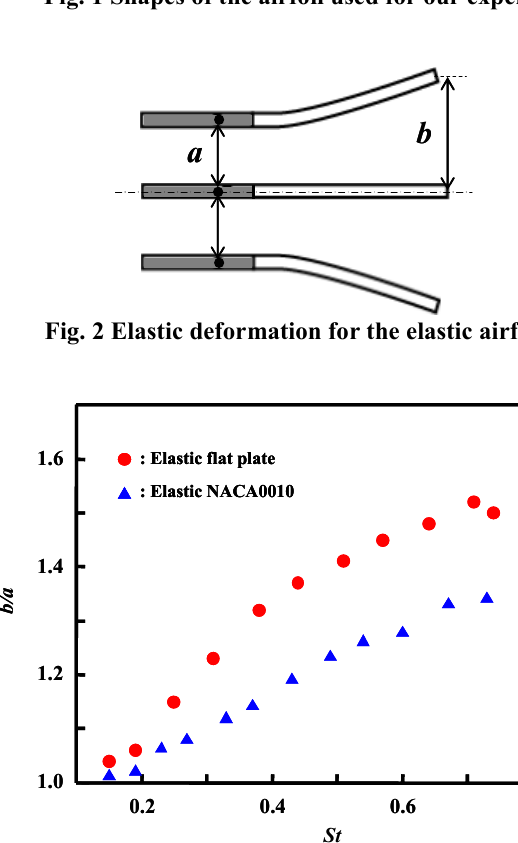
Fig. 1 Shapes of the airfoil used for our experiment